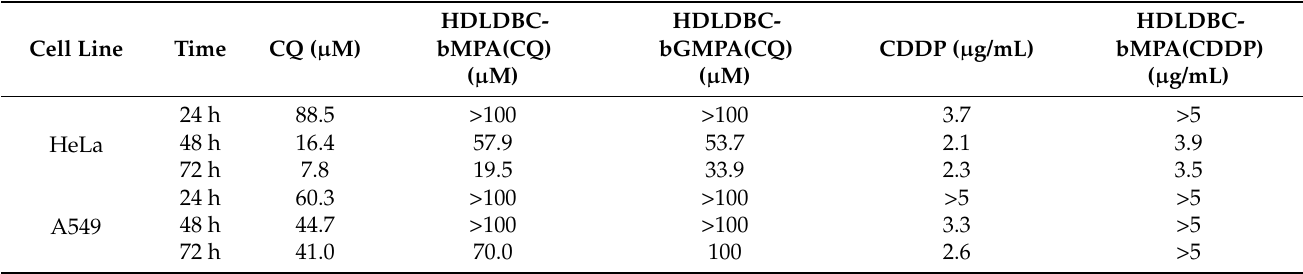
Table 3. Cytotoxic concentration values (CC50) for CQ and CDDP free or encapsulated on HDLDBCs against HeLa and A549 cell lines at different time